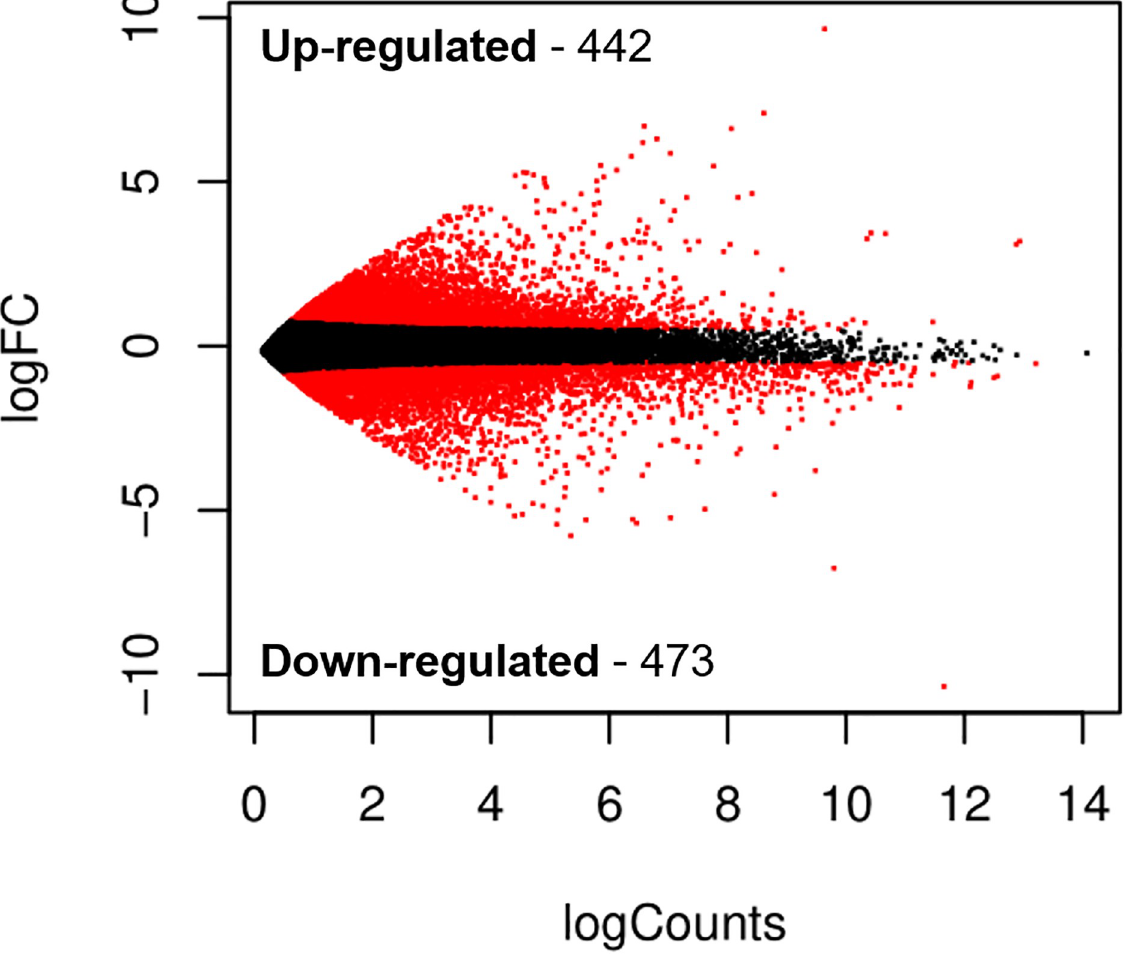
Fig 5. Differentially expressed transcripts. Volcano plot shows the DETs from shrimp hepatopancreas challenged with Vibrio parahaemolyticus 16IPNIAV13 at 24 hpi. Log counts in the X- axis indicate transcript log-abundance. LogFC in the Y- axis indicates fold change; each dot represents one gene; red dots are either up or down-regulated genes and black dots are genes with no differential expression.